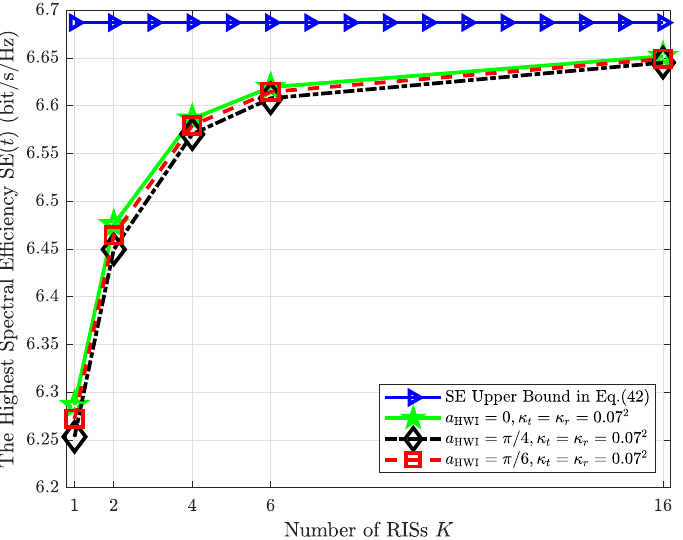
Figure 10. The highest spectral efficiency for one vehicle pass with different numbers of RISs K . K = 2,4,6,16, and M × N = 128 2 . Note that the upper bound for SE is based on (42).